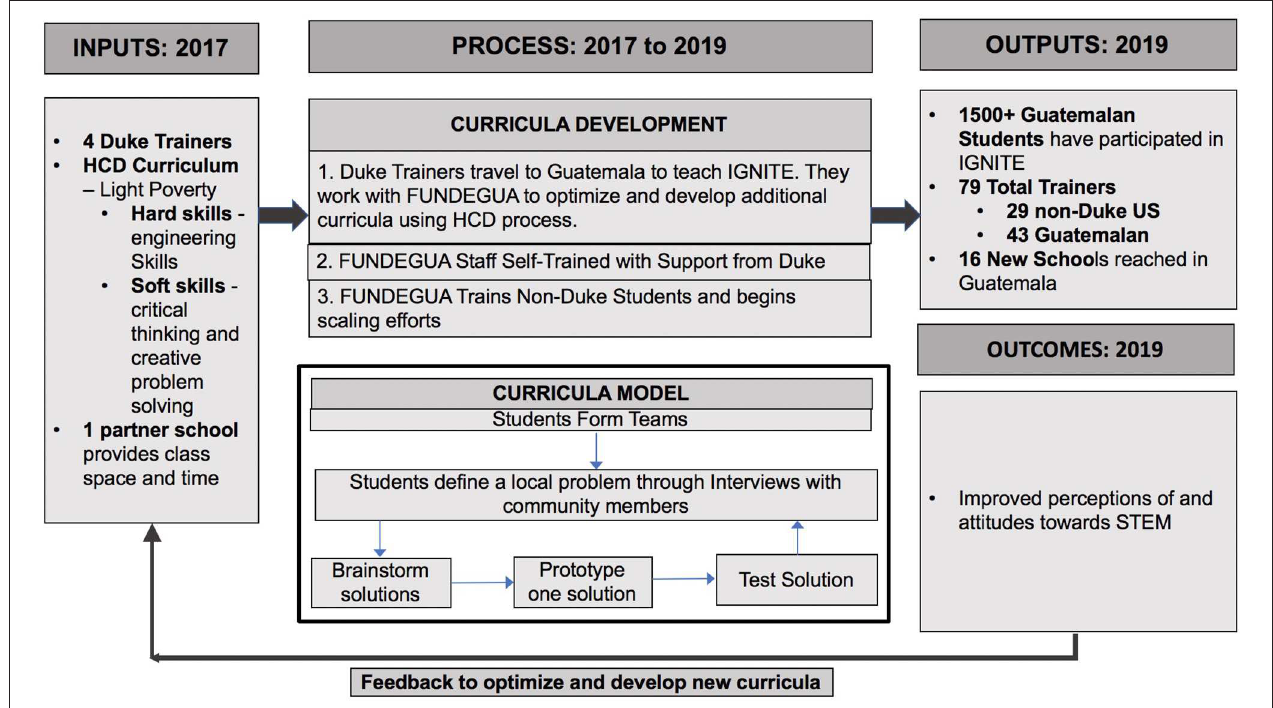
FIGURE 2 | Evolution of Ignite (Duke-FUNDEGUA Collaboration) in Sololá, Guatemala,